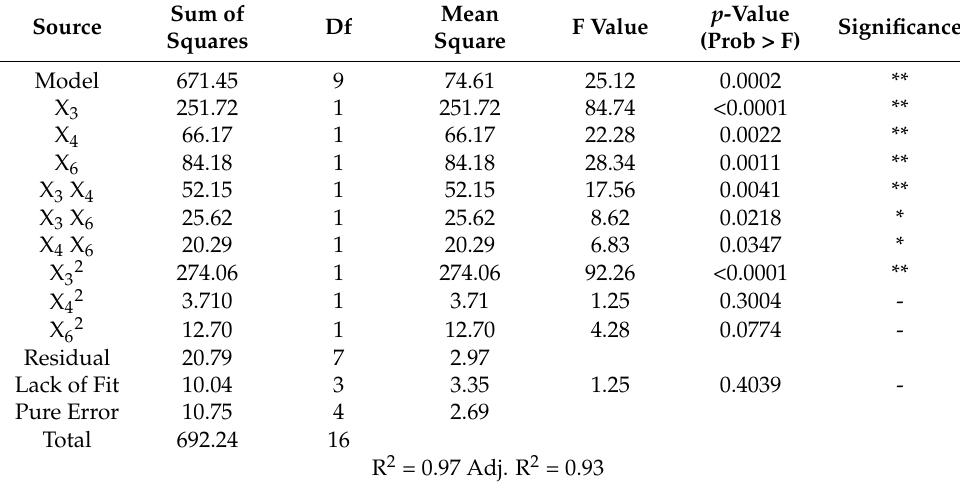
Table 4. ANOVA for response surface quadratic model of MgSO 4 rejection rate.